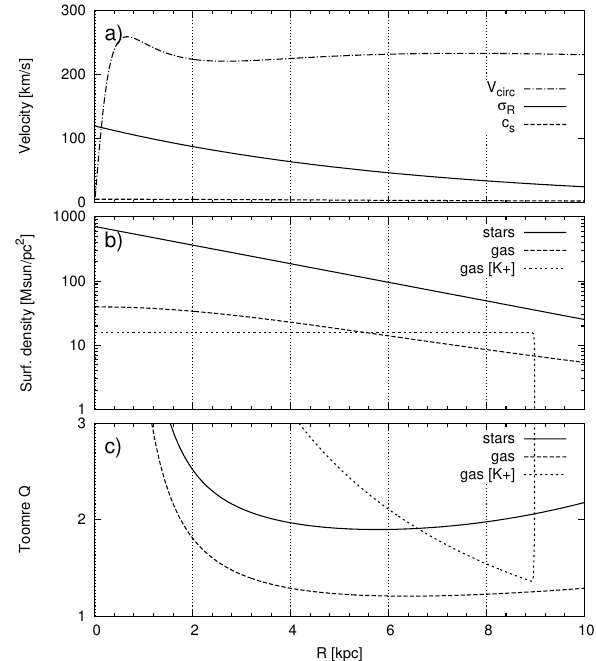
Figure 2. The Galaxy model profiles: a) the rotation curve V circ ( R ), the radial dispersion of the velocities of the stars σ ( R ) and the R turbulent sound speed c ( R ); b) the surface density of the stellar s and gaseous discs; c) Toomre parameters(7) for stellar and gaseous discs. In panels b) and c) the short dashes show the corresponding profiles for the gaseous disc for the initial parameters adopted in